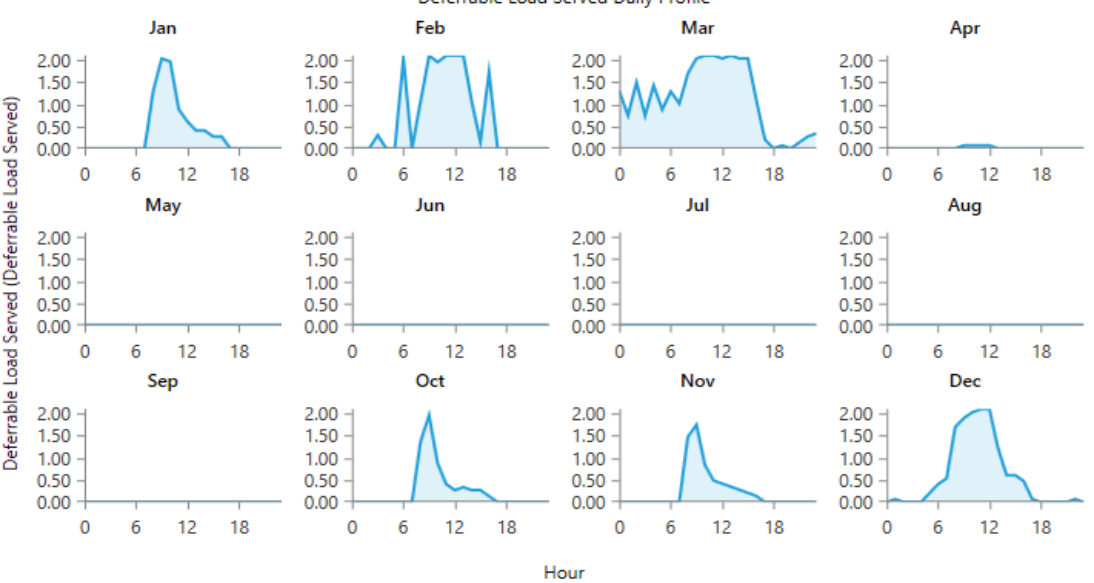
Figure 14. Electric load served (daily profile) at Site 10.